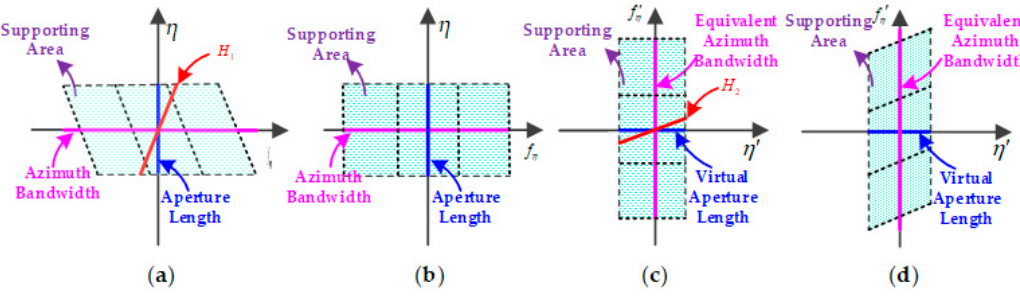
Figure 4. Steps of the frequency-domain processing using the time-frequency diagrams (TFDs). ( a ) Echo signal and reference function H 1 in the range/Doppler domain; ( b ) signal after deramping; ( c ) signal after inverse Fourier transform (IFT) with new IFT kernel and residual phase compensation function H 2 ; ( d ) signal after the residual phase compensation.